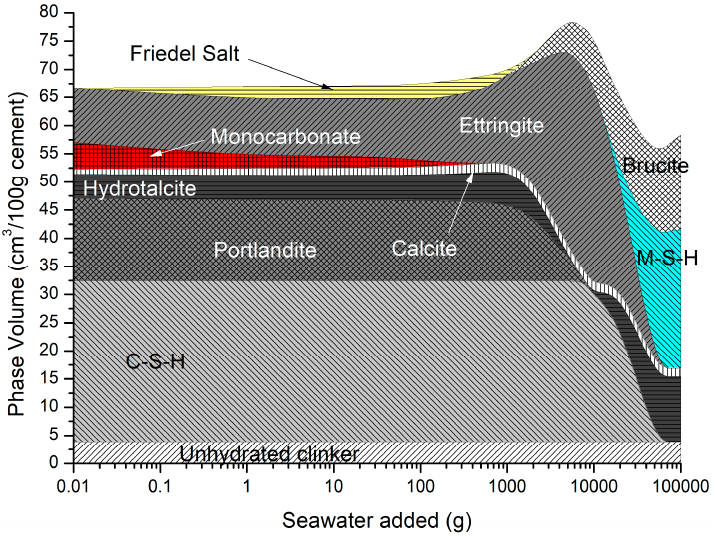
Figure 11. Phase assemblage during seawater ingress.